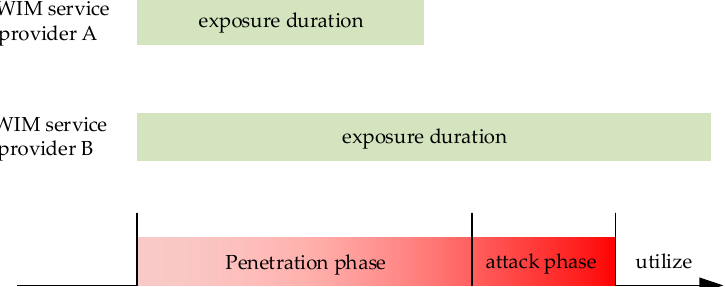
Figure 4. The attack process of a malicious attacker.